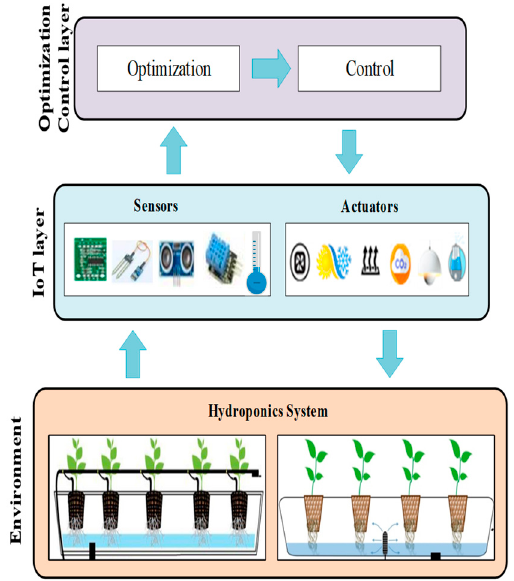
Figure 1. Hydroponics layered model with the proposed optimization and control scheme.